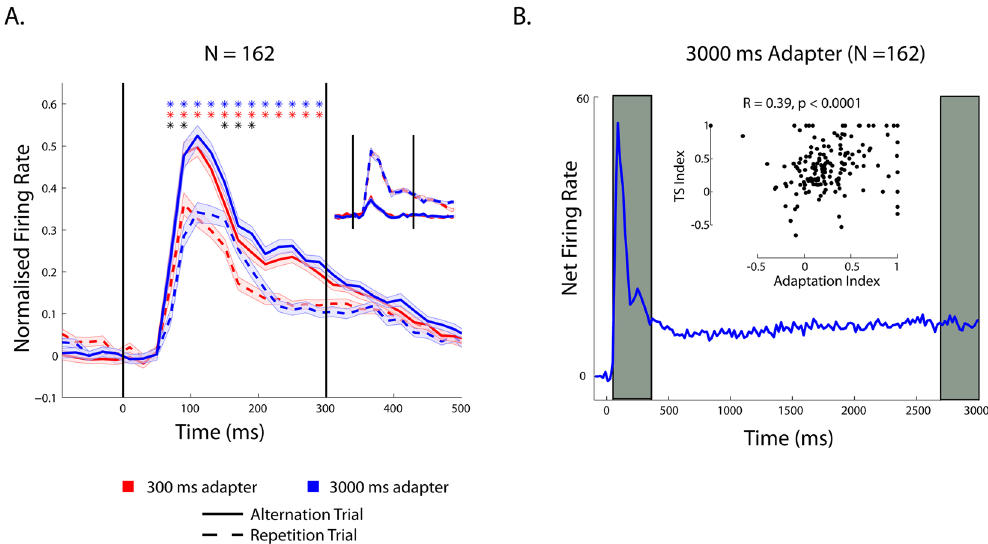
Figure 5. Time course of responses to test and adapter stimuli. ( A ) Normalized firing rate to test stimuli following the 300 and 3000 ms adapter in repetition and alternation trials. Average of all recorded single units. The inset shows the responses to the adapter stimuli in the same repetition and alternation trials for the first 500 ms of the two duration conditions. The blue and red stars indicate significant differences between the alternation and repetition trial test responses for the 3000 ms and 300 ms duration condition, respectively. The black stars indicate significant differences between the 300 and 3000 ms test stimulus responses in repetition trials. No differences between the two duration conditions were significant for the alternation trial test responses. Significant differences: Wilcoxon signed rank test: q < 0.05, corrected for multiple comparisons. Same conventions as in Fig. 2. ( B ) Mean net firing rate during the 3000 ms adapter, averaged across all single units. The shaded bars indicate the time windows employed to compute the TS index. Inset panel: scatter plot of TS index versus adaptation index. A positive TS index corresponds to a relatively weaker sustained